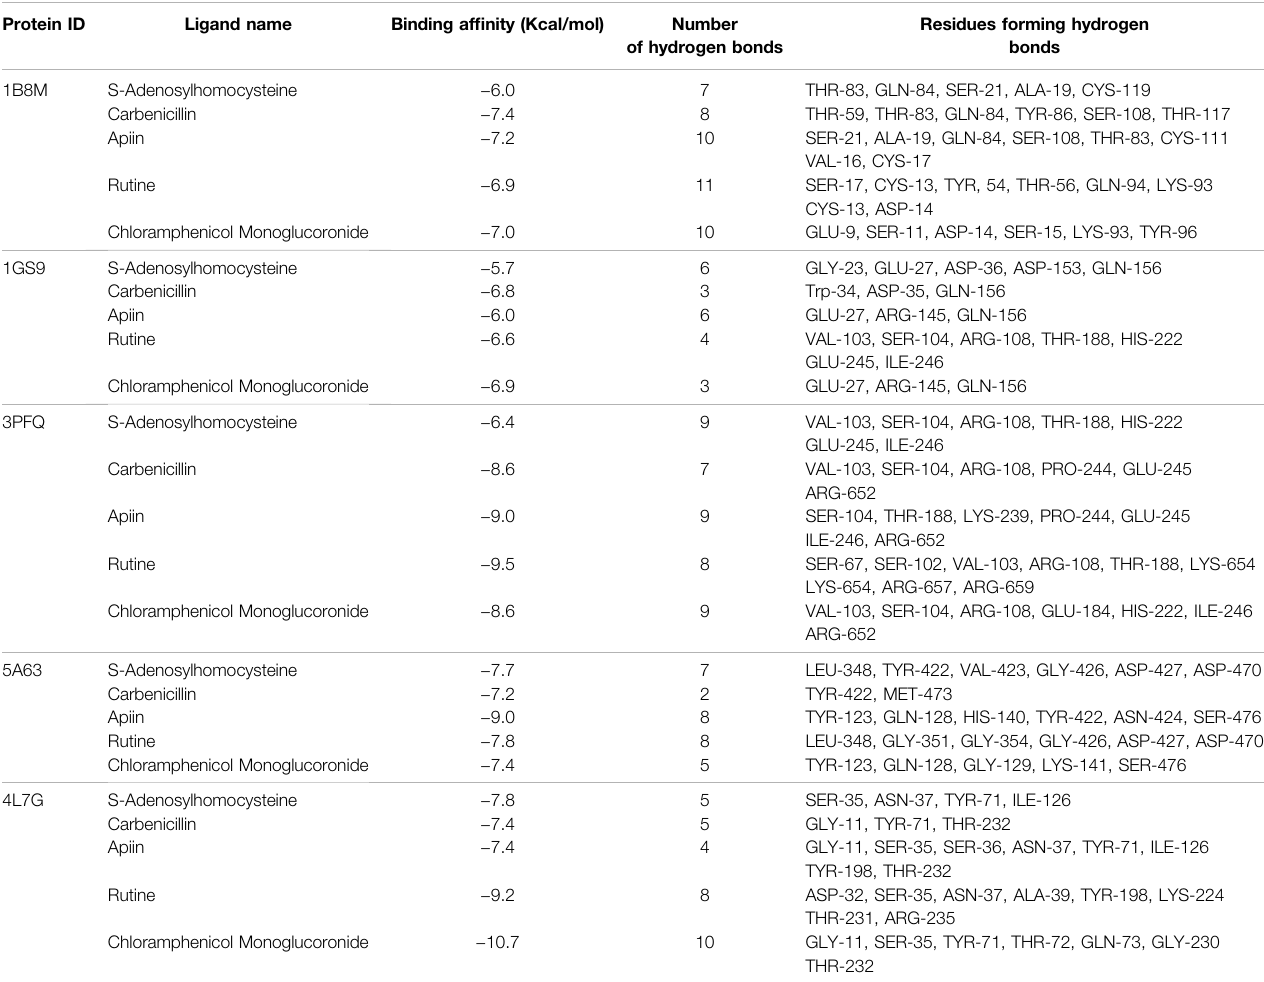
TABLE 1 | Protein-ligand complex binding energy and interaction details. Protein